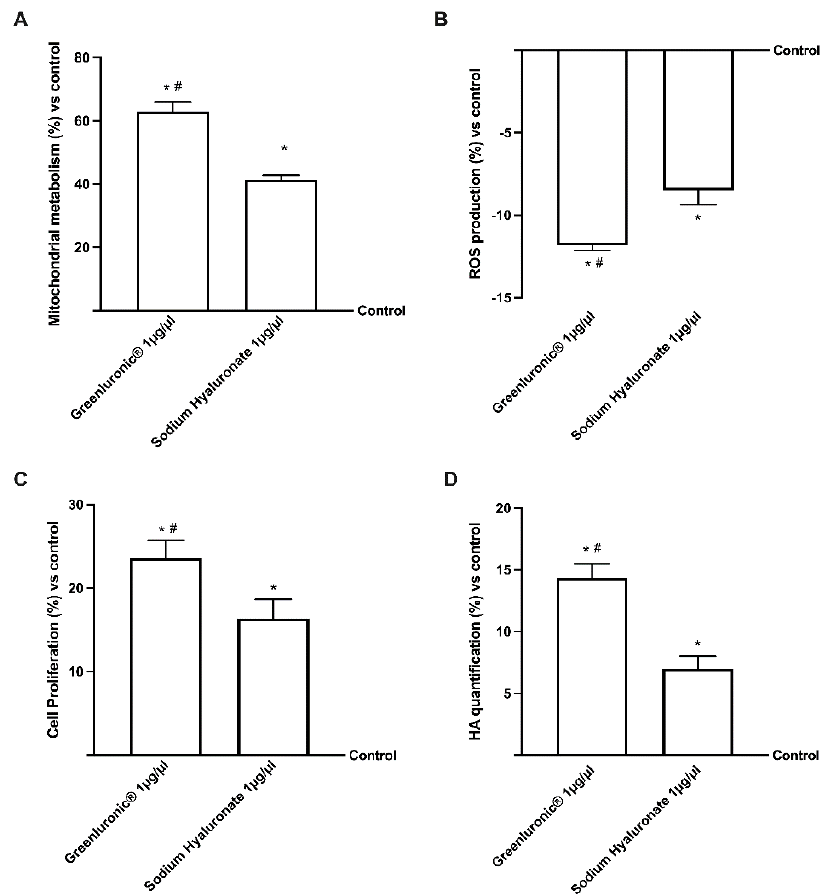
Figure 5. Analysis of GreenIuronic ® and Sodium Hyaluronate on human chondrocyte (T/C-28a2) cells functions. In ( A ) the mitochondrial metabolism tested by MTT test; in ( B ) the ROS production; in ( C ) the proliferation analysis by crystal violet assay; and in ( D ) the HA quantification by ELISA kit. Data are expressed as mean ± SD compared to control (0% line) of five independent experiments performed in triplicates. * p < 0.05 vs. control; # p < 0.05 vs. Sodium Hyaluronate 1 µg/µL.